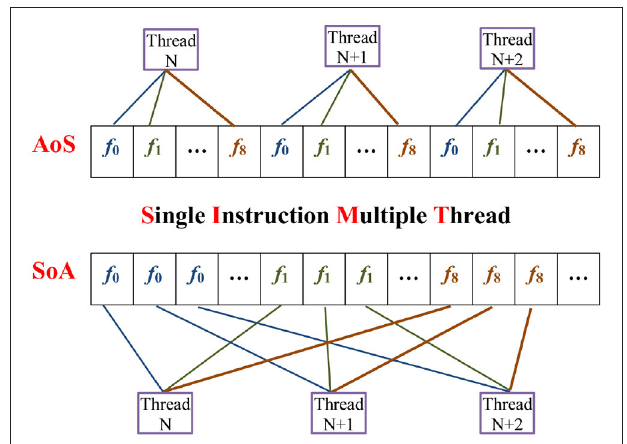
FIGURE 4 | Data structure of AoS and